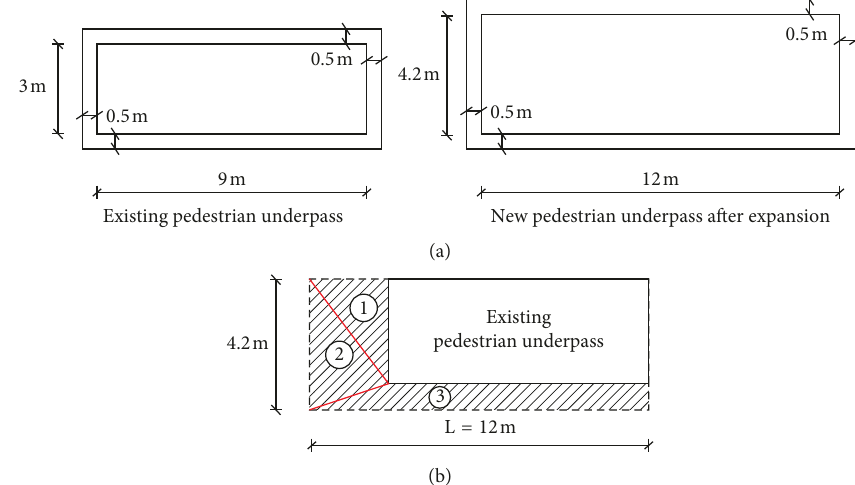
Figure 4: (a) Characteristic dimensions of existing and new pedestrian underpass; (b) construction scheme and sequence.